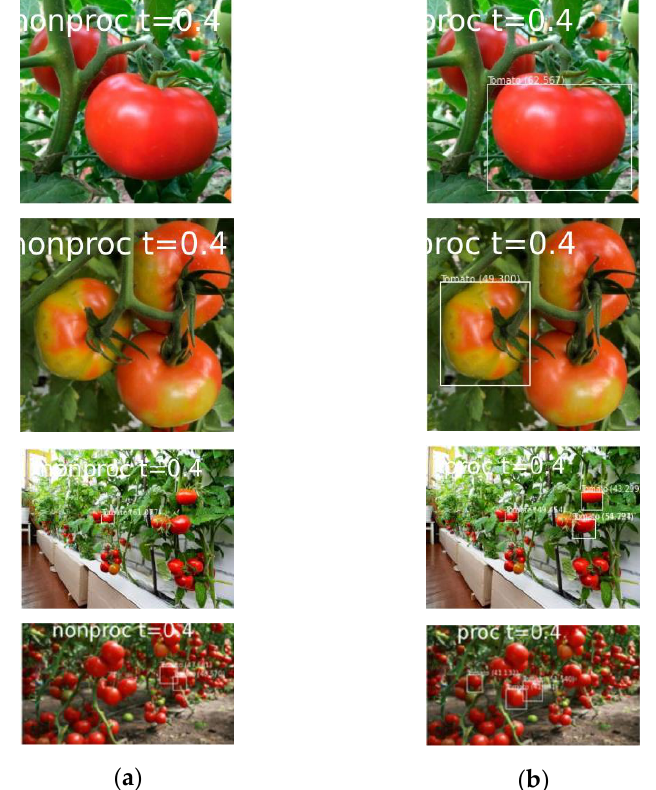
Figure 14. Detecting tomatoes on images by YOLOv3 without pre-processing ( a ) and with pre-processing ( b ).